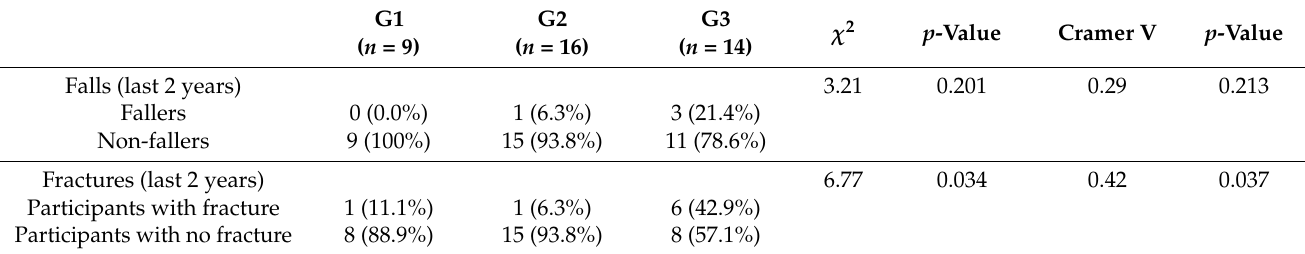
Table 3. Number of participants experiencing fall and/or fracture